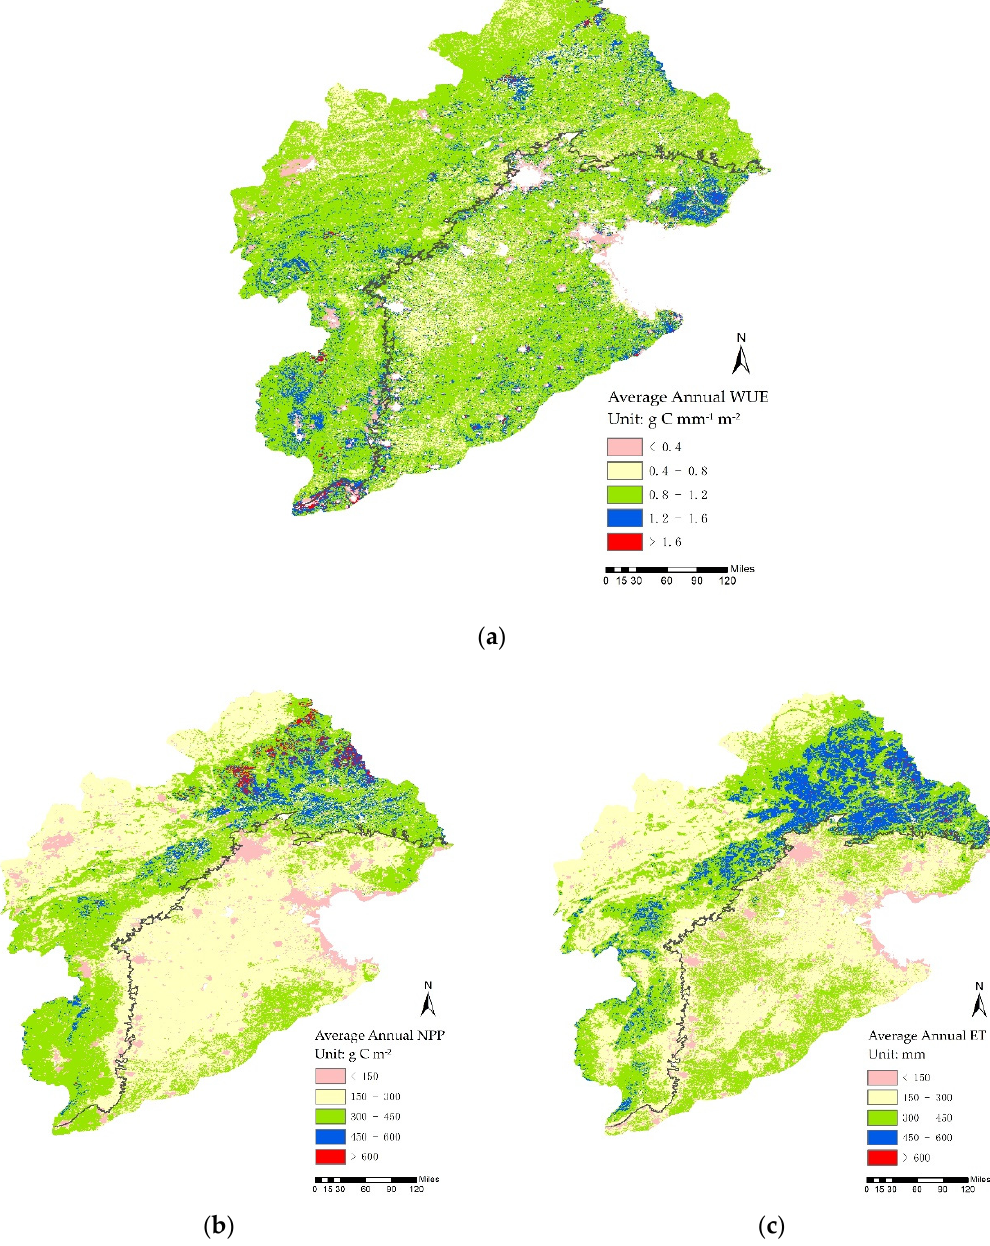
Figure 8. Spatial distributions of the average annual WUE ( a ), average annual NPP ( b ), and average annual ET ( c ) from 2005 to 2015 in the Haihe River Basin.